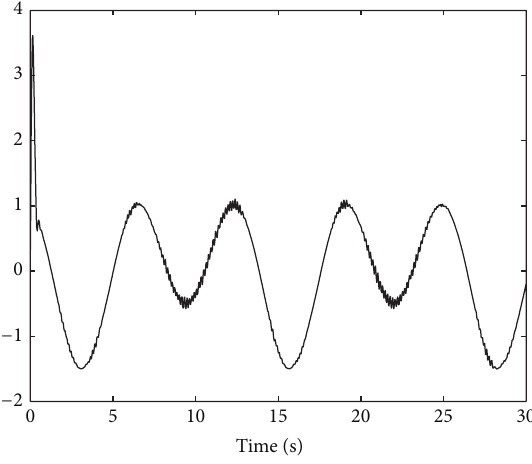
Figure 2: Trajectory of the system state 𝑥 2